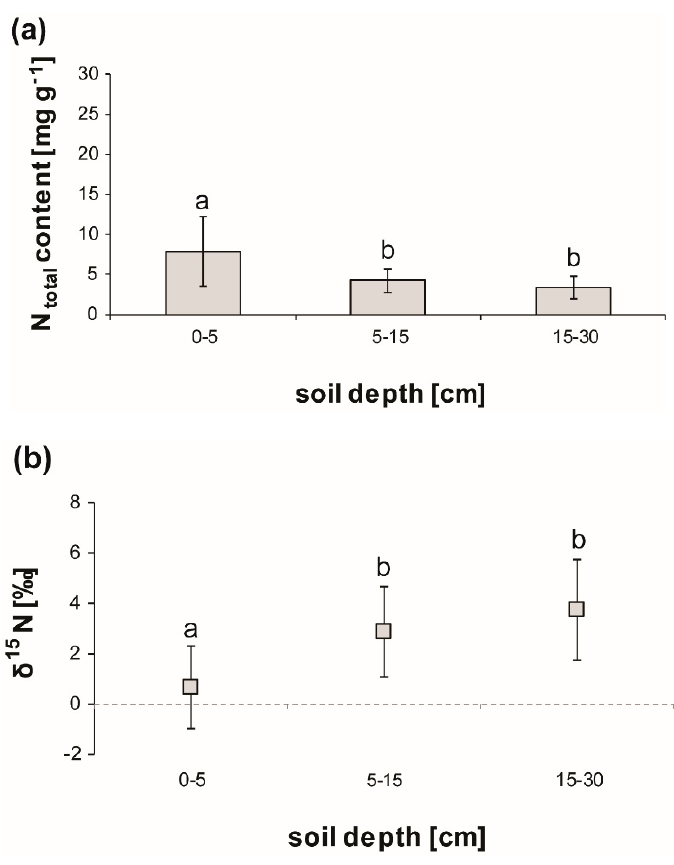
Figure 1. Total N content (a) and δ 15 N (b) in soil layers under Fagus crenata Blume. The error bars denote SD ( n = 9), p < 0.05.